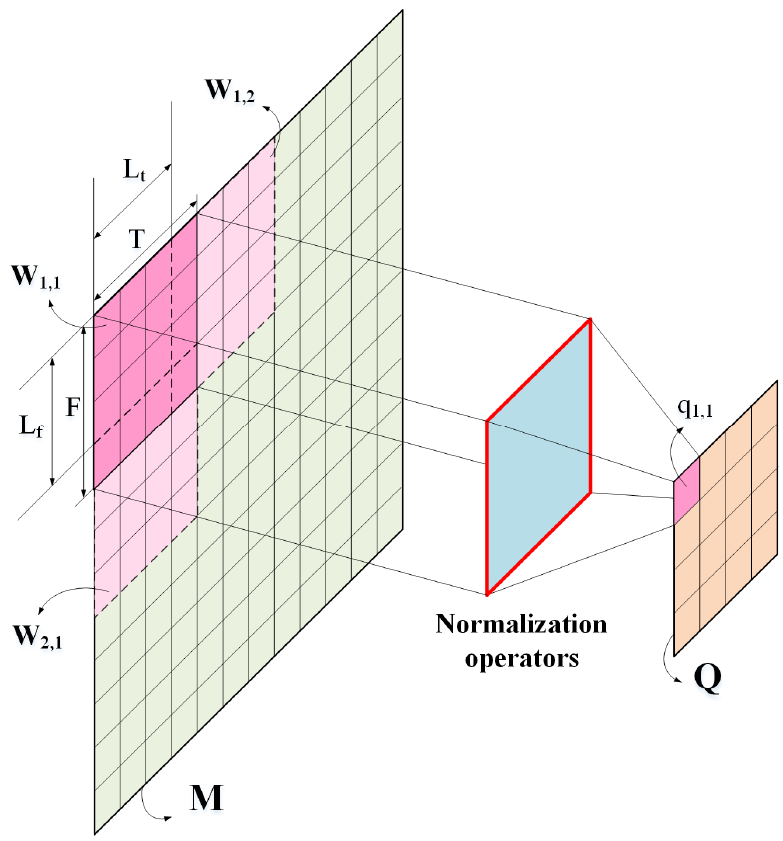
Figure 3. Matrix division and normalization operations using time-frequency entropy (TfEn).